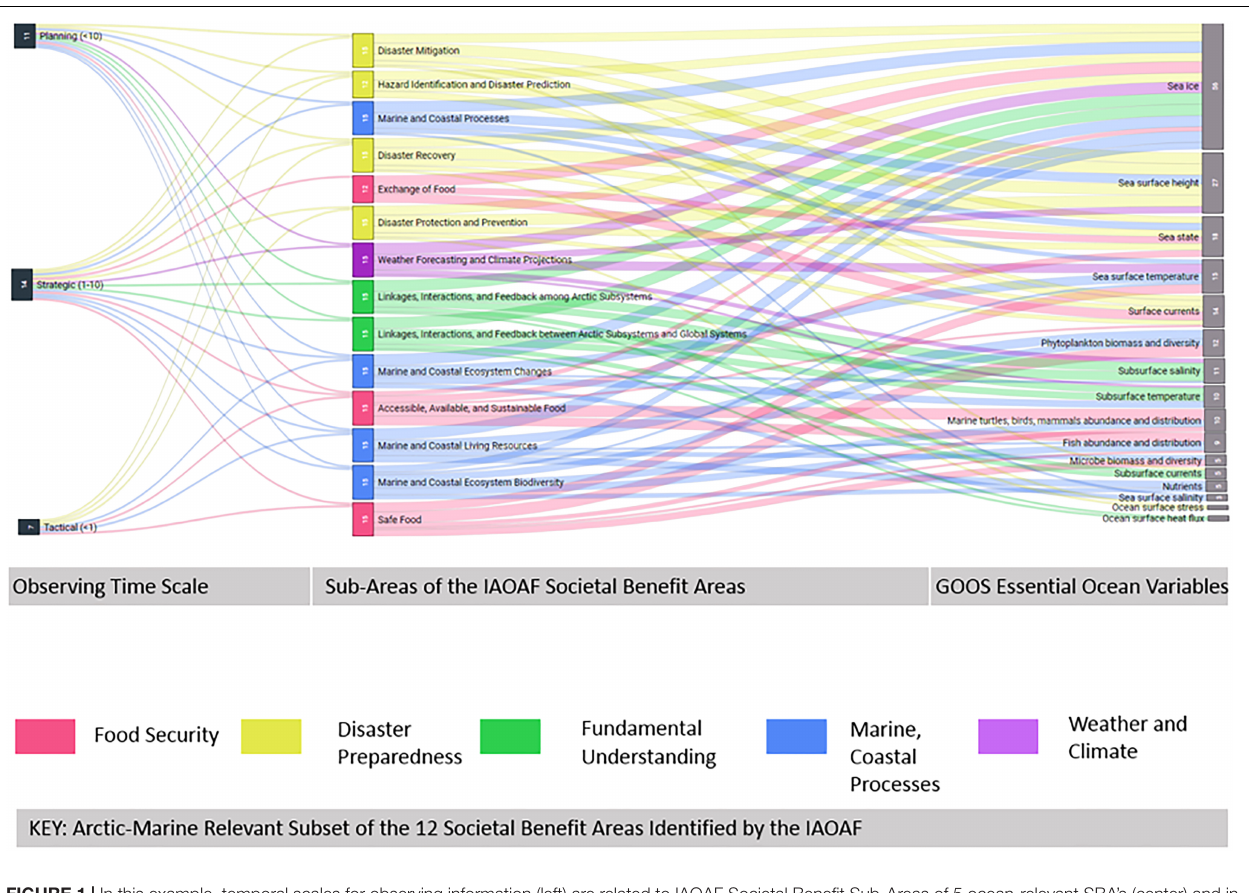
FIGURE 1 | In this example, temporal scales for observing information (left) are related to IAOAF Societal Benefit Sub-Areas of 5 ocean-relevant SBA’s (center) and in turn linked to GOOS EOV’s of highest impact to that topic. Through such relational mapping, the IAOAF can support the design of ARCGOOS through: (1) clarifying the user base for the observing system; (2) demonstrating variables of highest common dependence; (3) identifying the range of interests that will impact how those variables are observed and data is